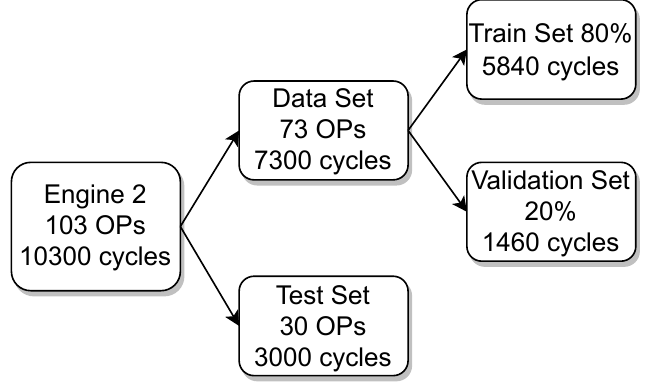
Figure 2. Datasets and performed splits of engine 1.